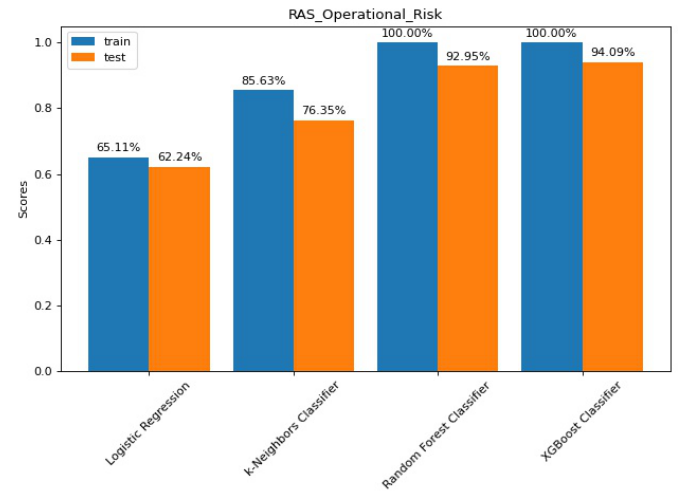
Figure 7. F1-scores of each model, using train-test split approach.